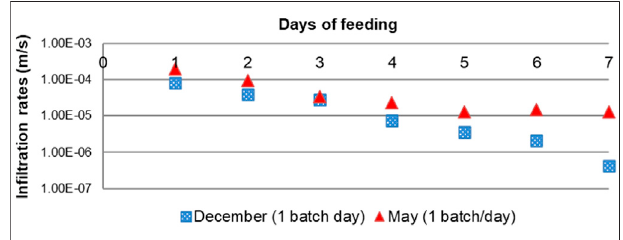
FIGURE8| In fi ltrationratesduringoneweekintheVFCWs(1batch/day, winter and